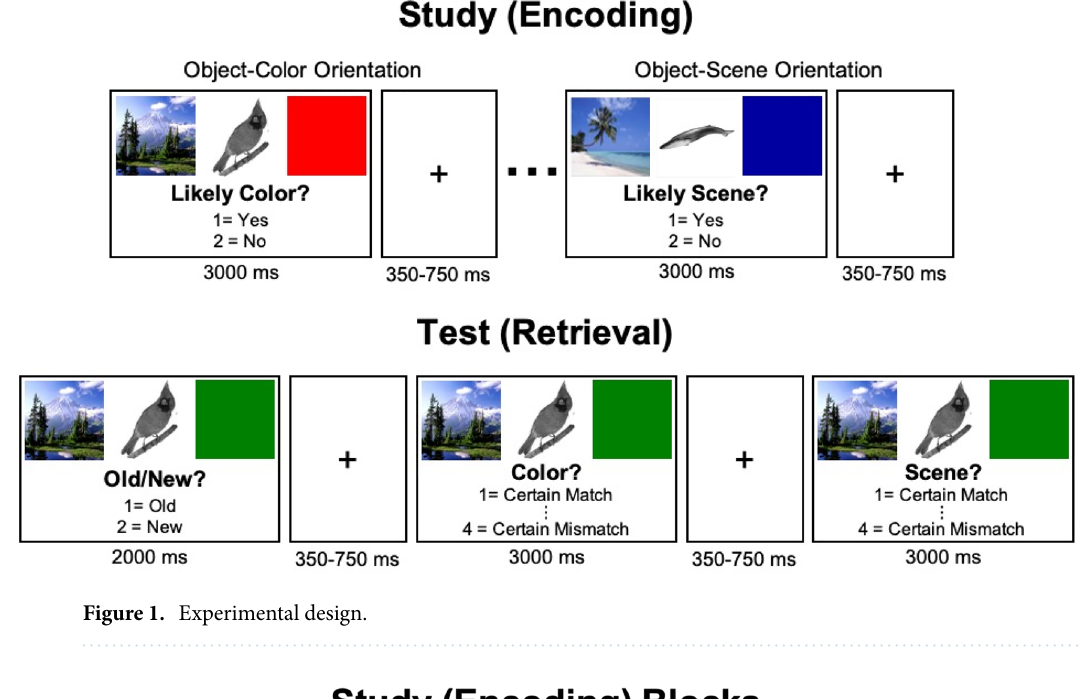
Figure 1. Experimental design.